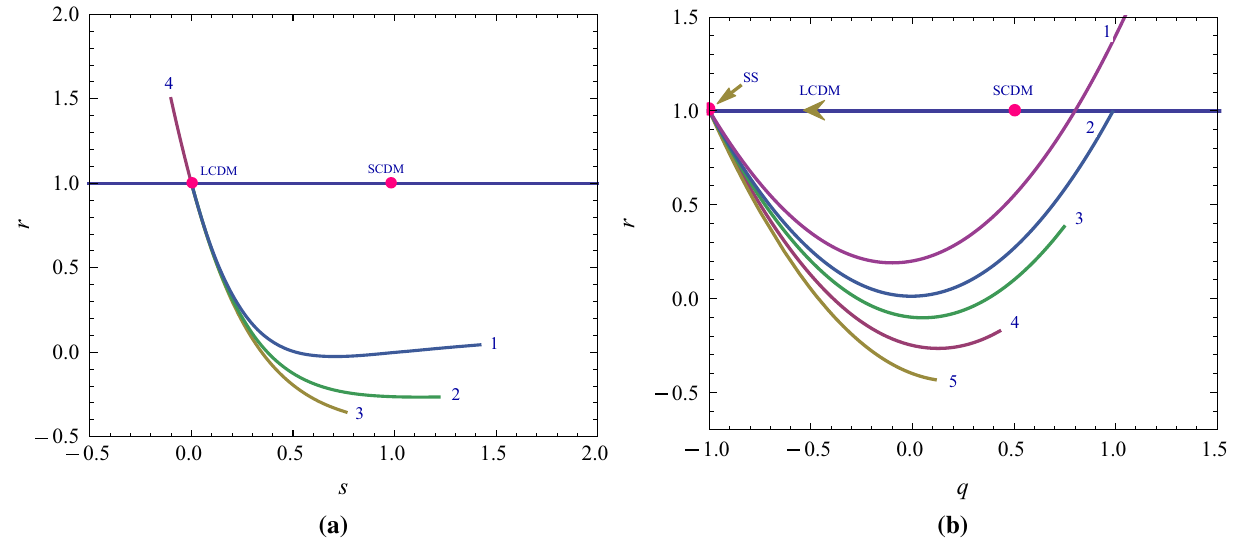
Fig. 5 The figure a plots the r − s trajectories and the figure b plots the r − q trajectories. We have taken H 0 = 10, M p = 1, c = 1 and t 0 = 1 to plot the trajectories. In figure ( a ), the trajectory 1 is plotted for w = − 0 . 35 and ζ = 1 / 5, the trajectory 2 is plotted for w = − 0 . 5 and ζ = 1 / 3, the trajectory 3 is plotted for w = − 0 . 6 and ζ = 1 / 3 and